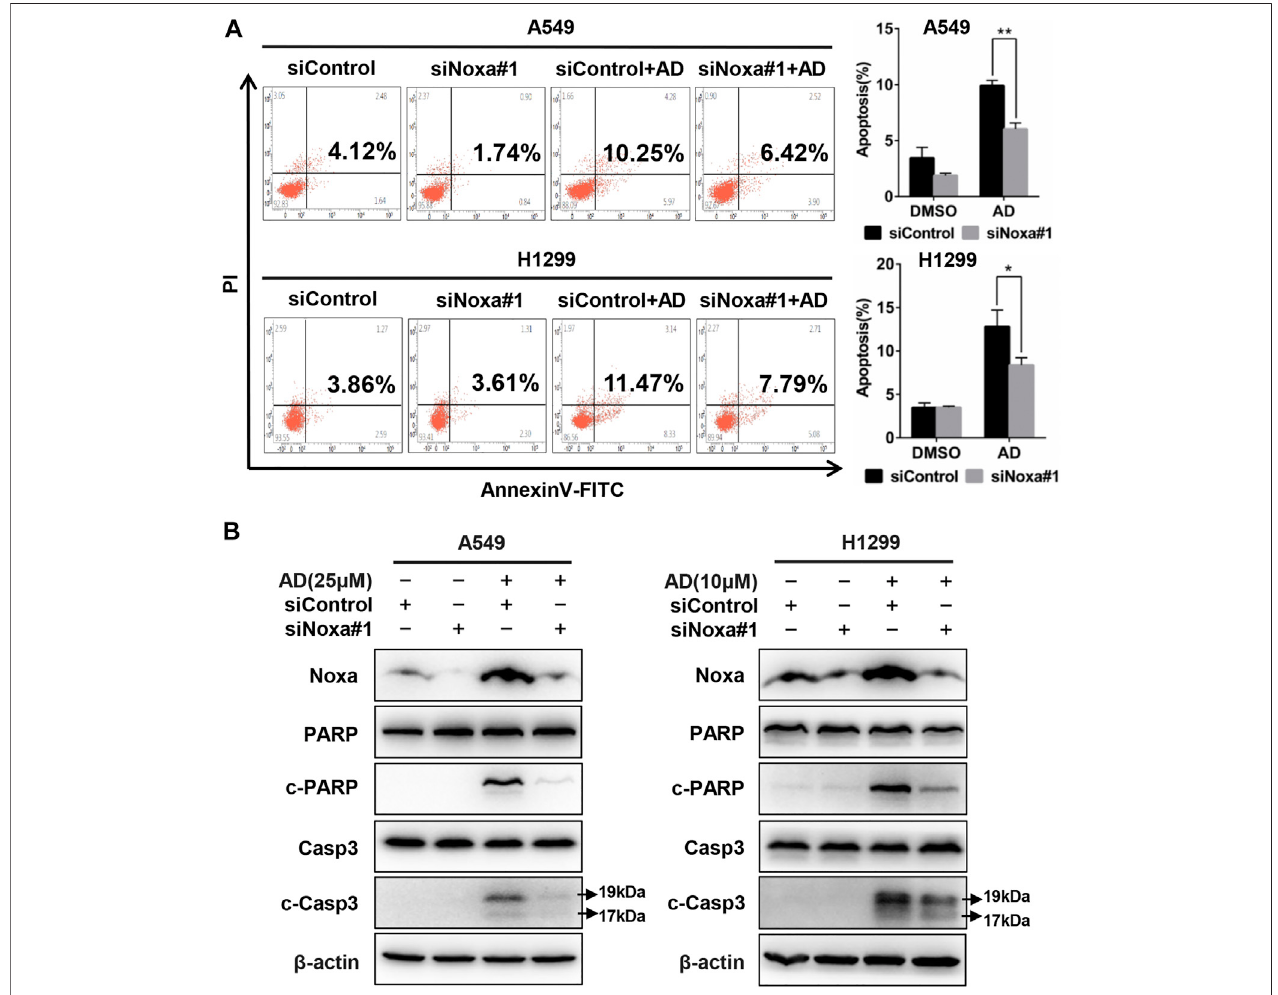
FIGURE 4 | Noxa knockdown signi fi cantly decreased andrographolide-induced apoptosis in human lung adenocarcinoma cells. (A) Cells were transfected with siControl or siNoxa#1 and treated with 1 ‰ DMSO and AD (A549 25 μ M and H1299 10 μ M) for 24 h. Apoptosis was determined and quanti fi ed with Annexin V-FITC/PI staininganalysis. (B) CellproteinwasextractedanddetectedbywesternblottingwithantibodiesagainstNoxa,PARP,c-PARP,Casp3,c-Casp3,and β -actin(* p ≤ 0.05; ** p ≤ 0.01).